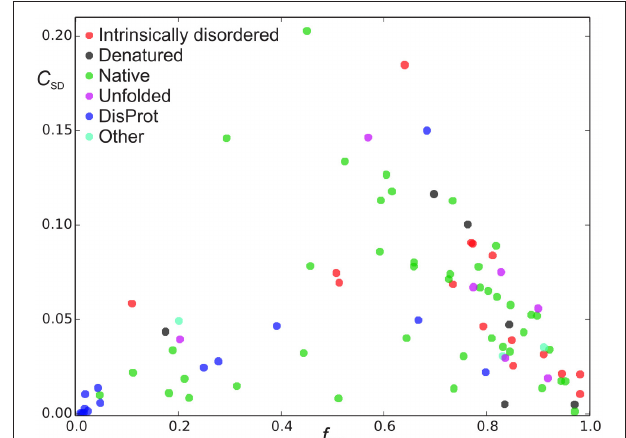
both at the local and global level, appear to be under-represented.